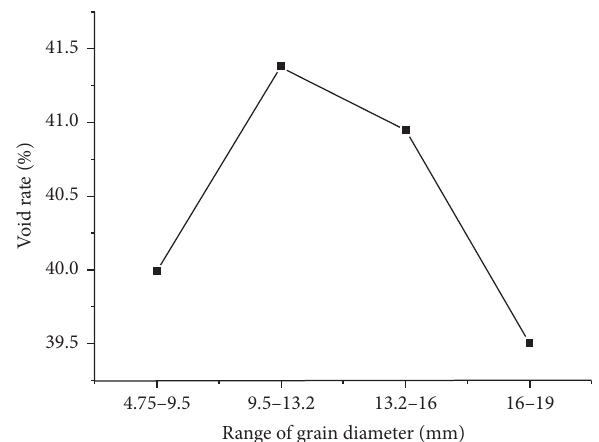
Figure 2: The void rate of different grain diameters of coarse aggregate.